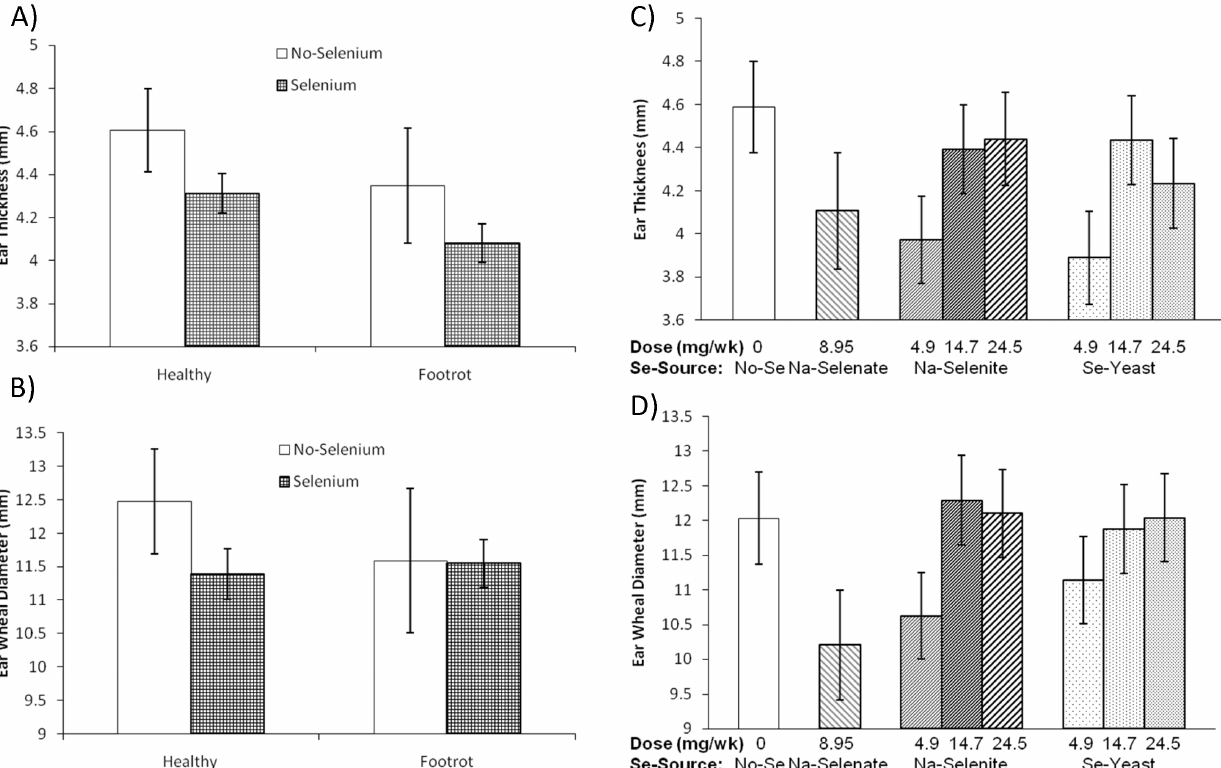
Figure 8. The effect of Se-source and dosage on 30-min skin response to keyhole limpet hemocyanin (KLH). The 30-min skin test response following KLH challenge was assessed after 52 wk of Se supplementation in healthy and footrot (FR)-affected sheep receiving no Se treatment, Na-selenate at a dosage rate of 8.95 mg Se/wk per ewe, or Na-selenite and Se-Yeast at 4.9, 14.7, or 24.5 mg Se/wk per ewe for 62 wk. A ) Ewes affected with FR had smaller 30 min ear-thickness responses to KLH intradermal injection than healthy ewes (overall P =0.05). B ) The 30 min ear- wheal diameter response was not significantly affected by ewe FR status or Se supplementation. C ) Selenium dosage, but not Se source affected the ear-thickness response, as Se supplementation at lower dosages (8.95 mg/wk Na-selenate, 4.9 mg/wk Na-selenite, and 4.9 mg Se-yeast/wk) had smaller ear-thickness responses than supranutritional Se supplementation (14.7 and 24.5 mg/wk Na-selenite and Se-yeast; P =0.01) or no Se supplementation ( P =0.01). D ) Selenium dosage, but not Se source affected the ear-thickness response, as Se supplementation at lower dosages had or tended to have smaller ear-wheel diameter responses than supranutritional Se supplementation ( P =0.03) or no Se supplementation ( P =0.07).